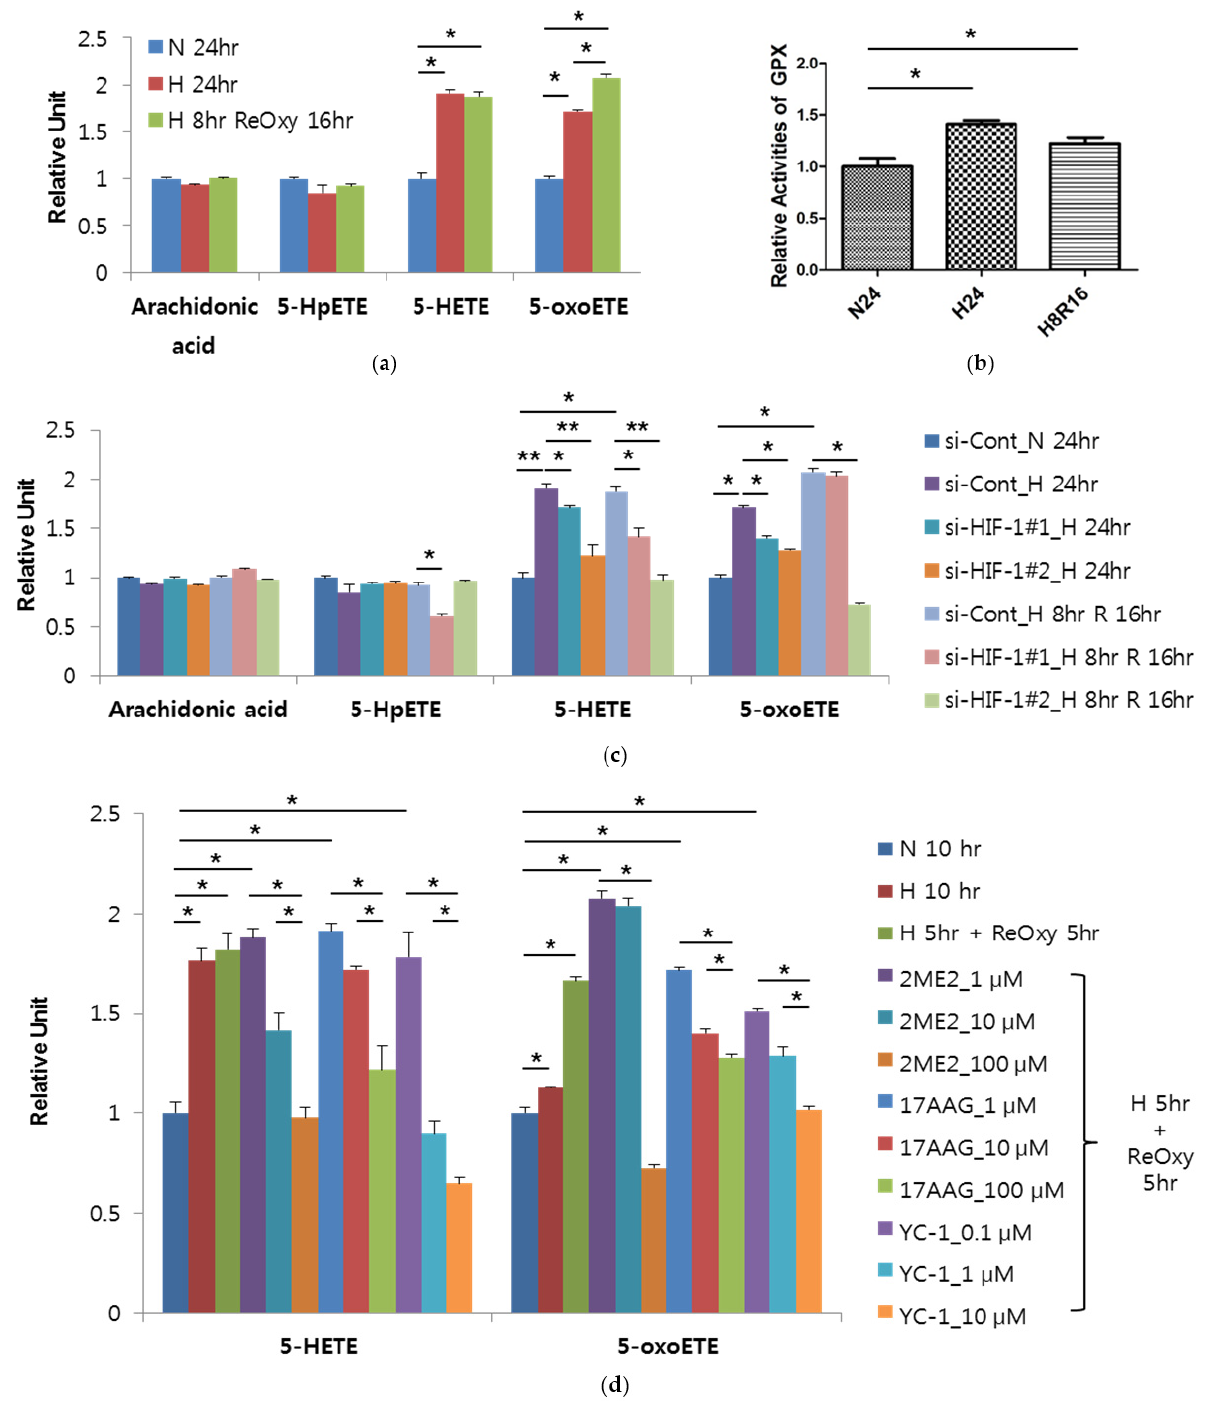
Figure 4. Augmented secretion of 5 ‐ HETE and 5 ‐ oxoETE from human monocytes by hypoxia. ( a ) Levels of arachidonic acid and its derivatives secreted from THP ‐ 1, a human monocyte cell line, by normoxia (N, 21% O2 for 24 h), hypoxia (H, 1% O2 for 24 h) or reoxygenation (ReOxy, 21% O2 for 16 h) after hypoxia (H, 1% O2 for 8 h). ( b ) Activity of glutathione peroxidase in primary human mononuclear cells under normoxic, hypoxic, or reoxygenation after hypoxia conditions. ( c ) Silencing of hypoxia ‐ inducible factor 1 α (HIF ‐ 1 α ) reduced the secretion of 5 ‐ HETE and 5 ‐ oxoETE from THP ‐ 1 cells by normoxia (N, 21% O2 for 24 h), hypoxia (H, 1% O2 for 24 h) or reoxygenation (R, 21% O2 for 16 h) after hypoxia (H, 1% O2 for 8 h). ( d ) HIF ‐ 1 inhibitors including 2 ‐ methoxyestradiol (2ME2), 17 ‐ (Allylamino) ‐ 17 ‐ demethoxygeldanamycin (17 ‐ AAG) and YC ‐ 1 inhibited 5 ‐ HETE and 5 ‐ oxoETE secretion from THP ‐ 1 cells. THP ‐ 1 cells were incubated in normoxia (N, 21% O2 for 10 h), hypoxia (H, 1% O2 for 10 h) or reoxygenation (R, 21% O2 for 5 h) after hypoxia (H, 1% O2 for 5 h). * p values < 0.05; ** p values < 0.01.